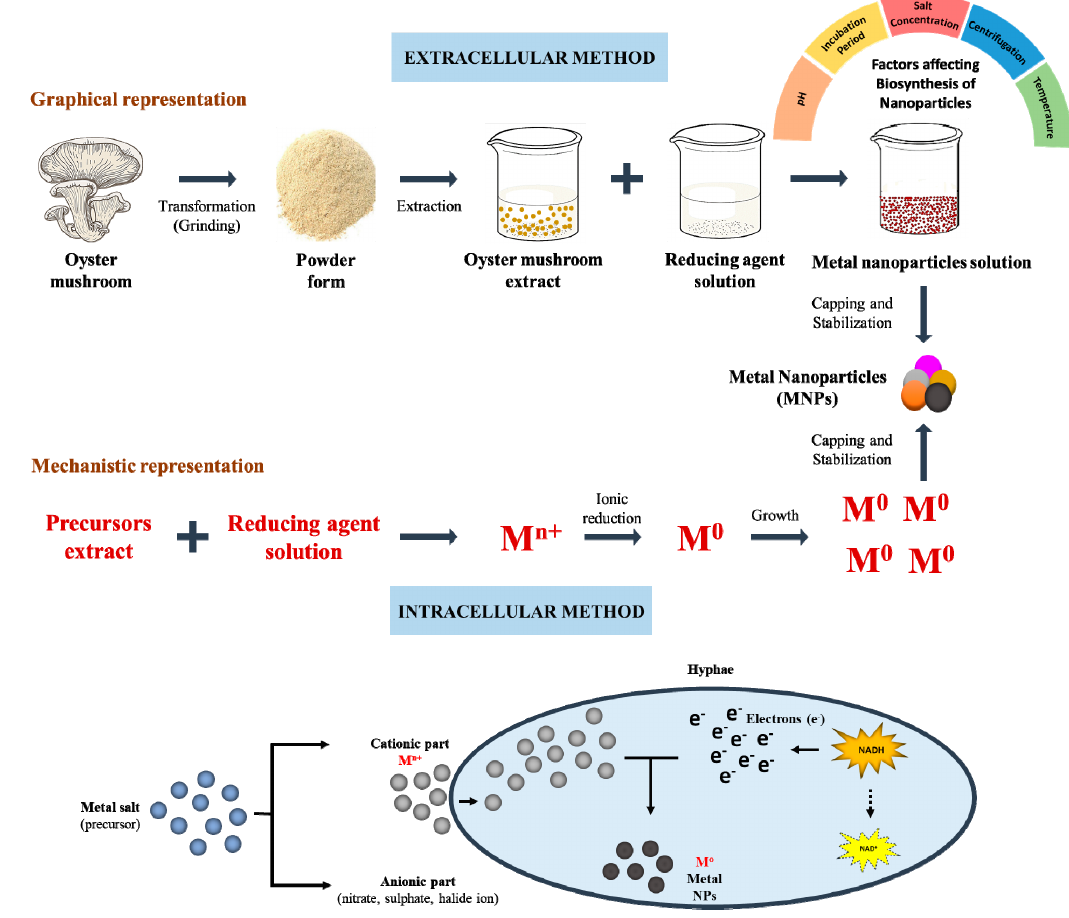
Figure 1. Graphical representation of green-synthesis of nanoparticles from Pleurotus (Oyster) Figure1. Graphicalrepresentationofgreen-synthesisofnanoparticlesfrom Pleurotus mushroom.